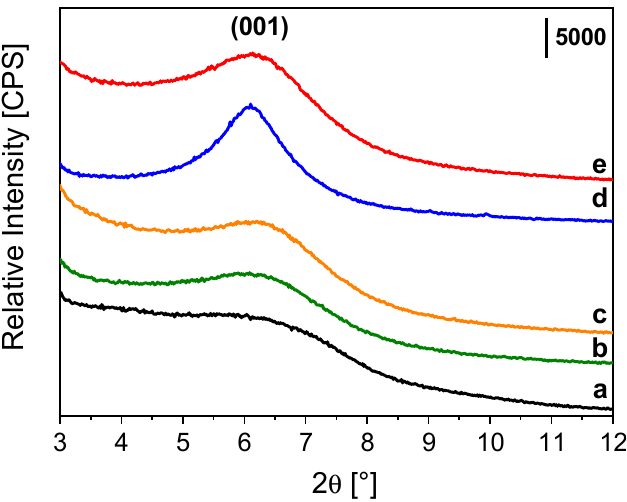
Figure 2. Diffractograms of saponite samples before and after impregnation with the aldehydes, collected in the 3–12° 2 θ range: Sap (a), SapC6AN (b), SapC6EN (c), SapC7AN (d) and SapC7EN (e).